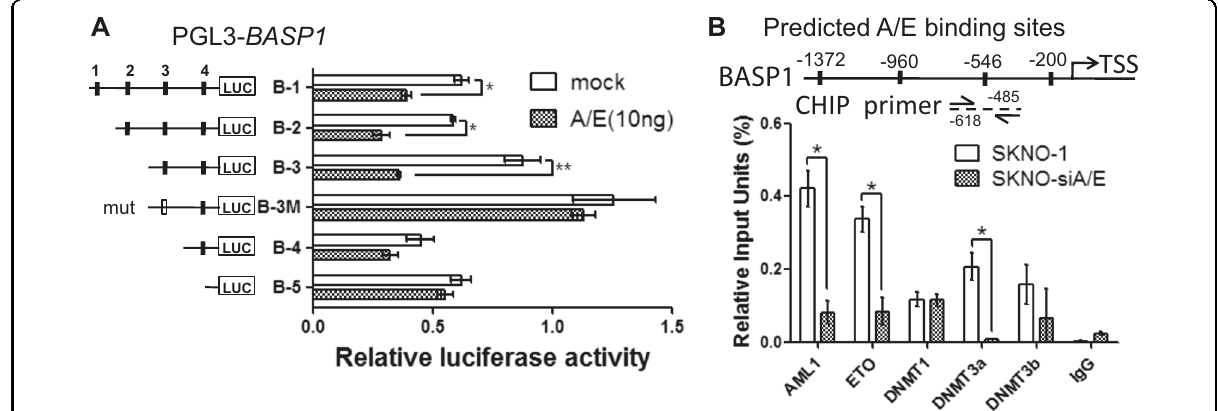
Fig. 3 A/E inactivates BASP1 through direct promoter binding. a The left diagram shows a luciferase reporter containing various lengths of the BASP1 promoter region with wild-type A/E-binding sites 1 – 4 or mutated sequence (mut). Luciferase reporter assays showed that A/E repressed the transcriptional activity of the BASP1 promoter. b ChIP was performed in the SKNO-1 and SKNO-1-siA/E cell lines using anti-AML1, anti-ETO, anti- DNMT1, anti-DNMT3a, and anti-DNMT3b antibodies or a non-speci fi c antibody (IgG control). Quantitative RT-PCR was performed with primers speci fi c for the BASP1 promoter region surrounding the predicted − 546/ − 556 binding site and expression was quanti fi ed as 2 − Δ CT relative to input. ChIP-PCR showed that A/E and DNMT3a bound the BASP1 promoter (* p < 0.05, ** p < 0.01)